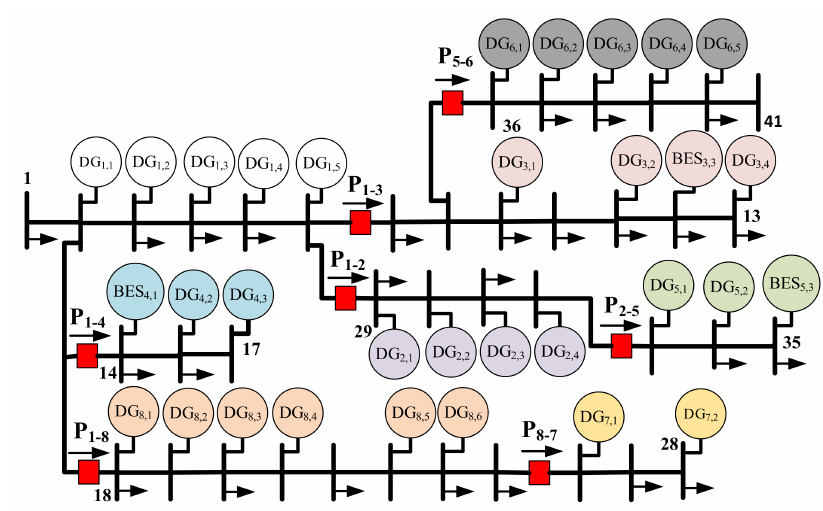
Figure 10. Diagram of simulated 41-node large-scale power